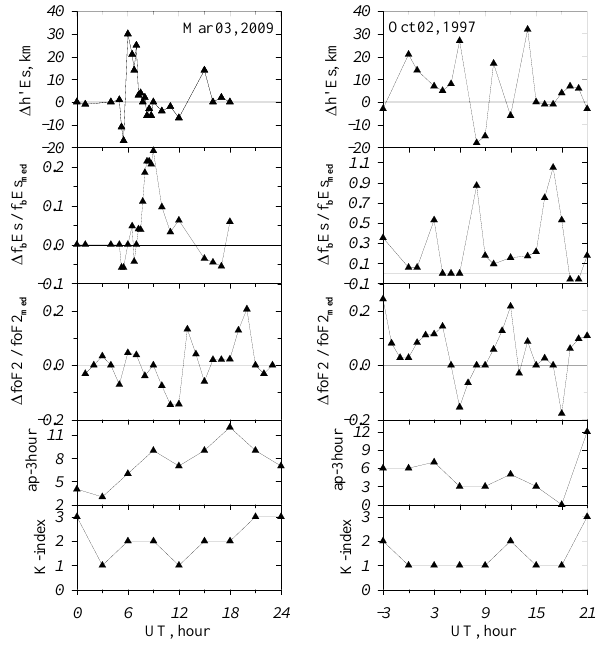
Fig. 2a. The precursors identification for the 6 April 2009 (left panel) and 14 October 1997 (right panel) earthquakes using ob- served 1h 0 Es, δ fb Es, and δ fo F2 variations. 3-h ap and local K- indices are given in lower